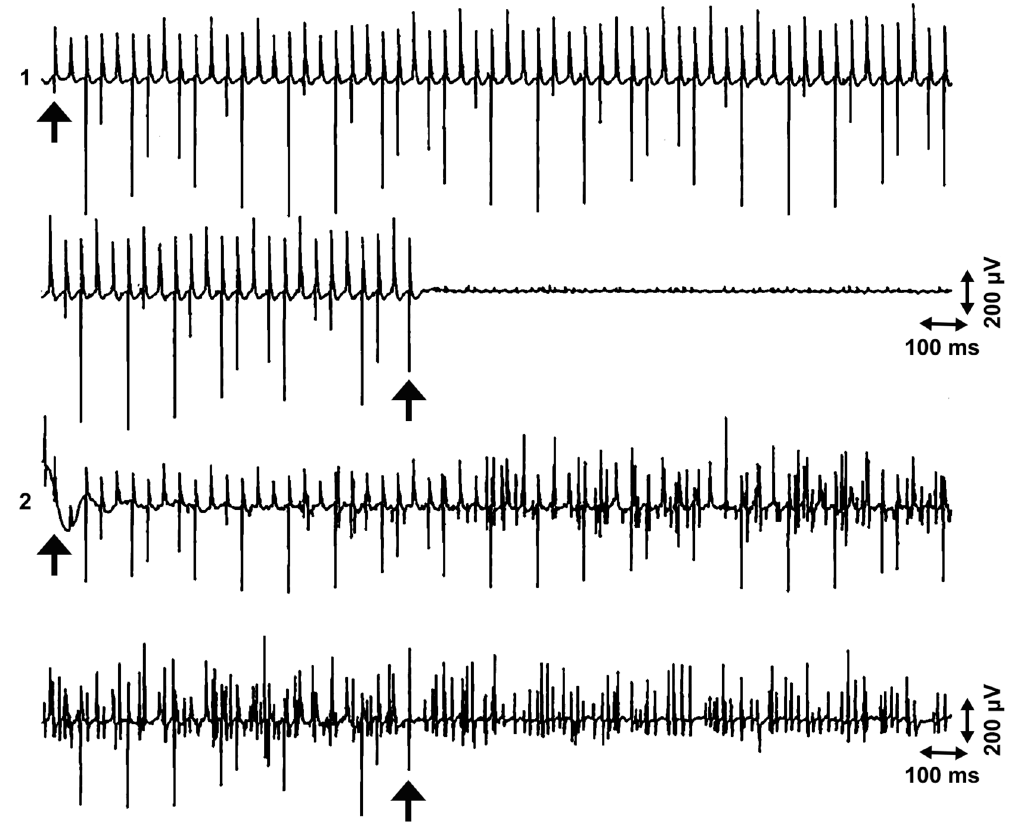
Figure 6. Activation of end plate spikes by high-frequency stimulation. Two-channel recording of the first interosseus dorsalis muscle. Channel 1: silent site; channel 2: active site with end plate spikes. High-frequency stimulation 30 Hz (start and stop, arrows; see stimulus artifact spikes), below the motor threshold, but above the sensory threshold, of the ulnar nerve at the wrist. No EMG activation at the silent site, but powerful activation of end plate spikes at the active